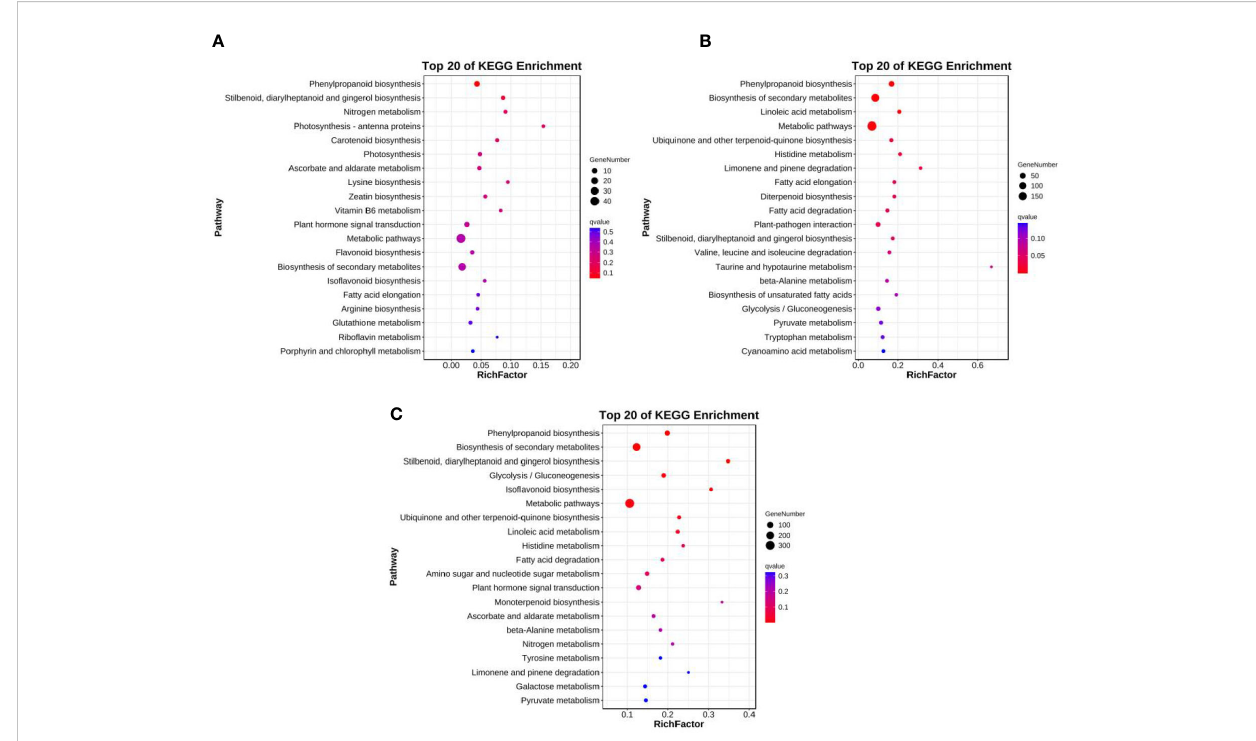
FIGURE 3 Top 20 enriched KEGG pathways in (A) line 01549, (B) line 08518, and (C) the comparison of lines 01549 and 08518 under low-P stress.